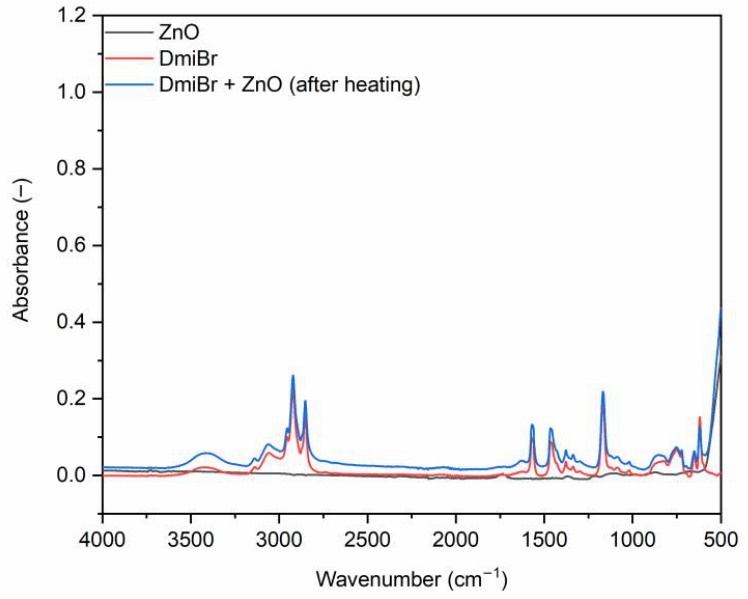
Figure 5. FTIR spectra for ZnO and DmiBr mixture after heating at 70 °C for 30 min.